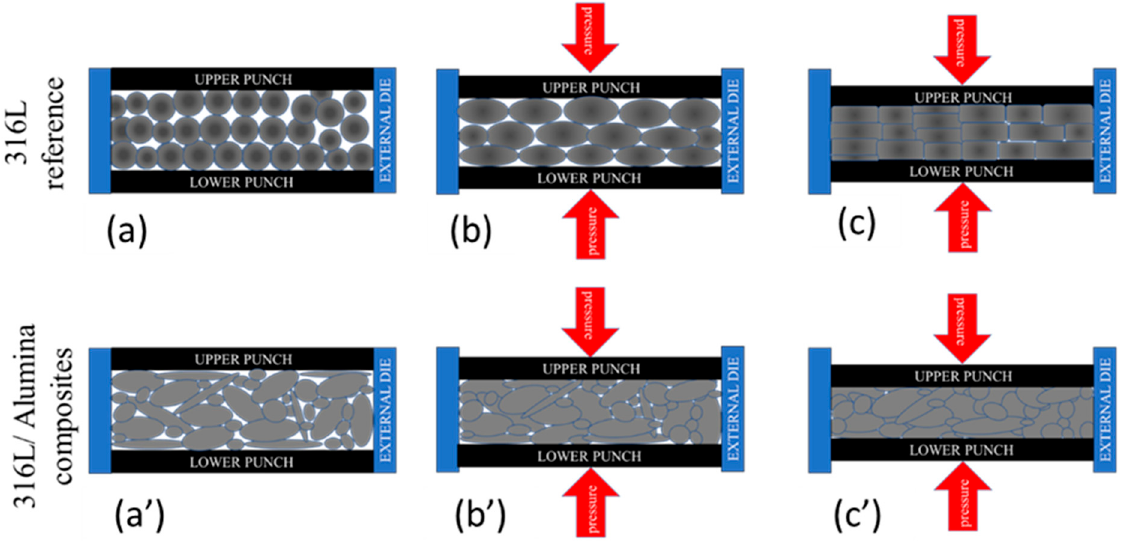
Figure 8. Schematic representation of the grains’ texture under plastic deformation during the sintering process. ( a , a’ ) Initial arrangement; ( b , b’ ) applying pressure; ( c , c’ ) sintered sample under pressure. The sintered 316L/0.33 wt% Al 2 O 3 samples had the main lines of 2 θ = 43.536 ◦ , 50.692 ◦ and 74.536 ◦ , with an average deviation of 0.003 ◦ from the corresponding JPC2:03-065-513 lines. The sintered 316L/1 wt% Al 2 O 3 had the main lines of 2 θ = 43.547 ◦ , 50.660 ◦ and 74.539 ◦ , with an average deviation of 0.009 ◦ from the corresponding JPC2:03-065-513 lines. In all sintered composites, we observed that both the first (111) and the third (220) peaks shifted to the right, and the second peak (200) shifted to the left in comparison with the JPC2:03-065-5131